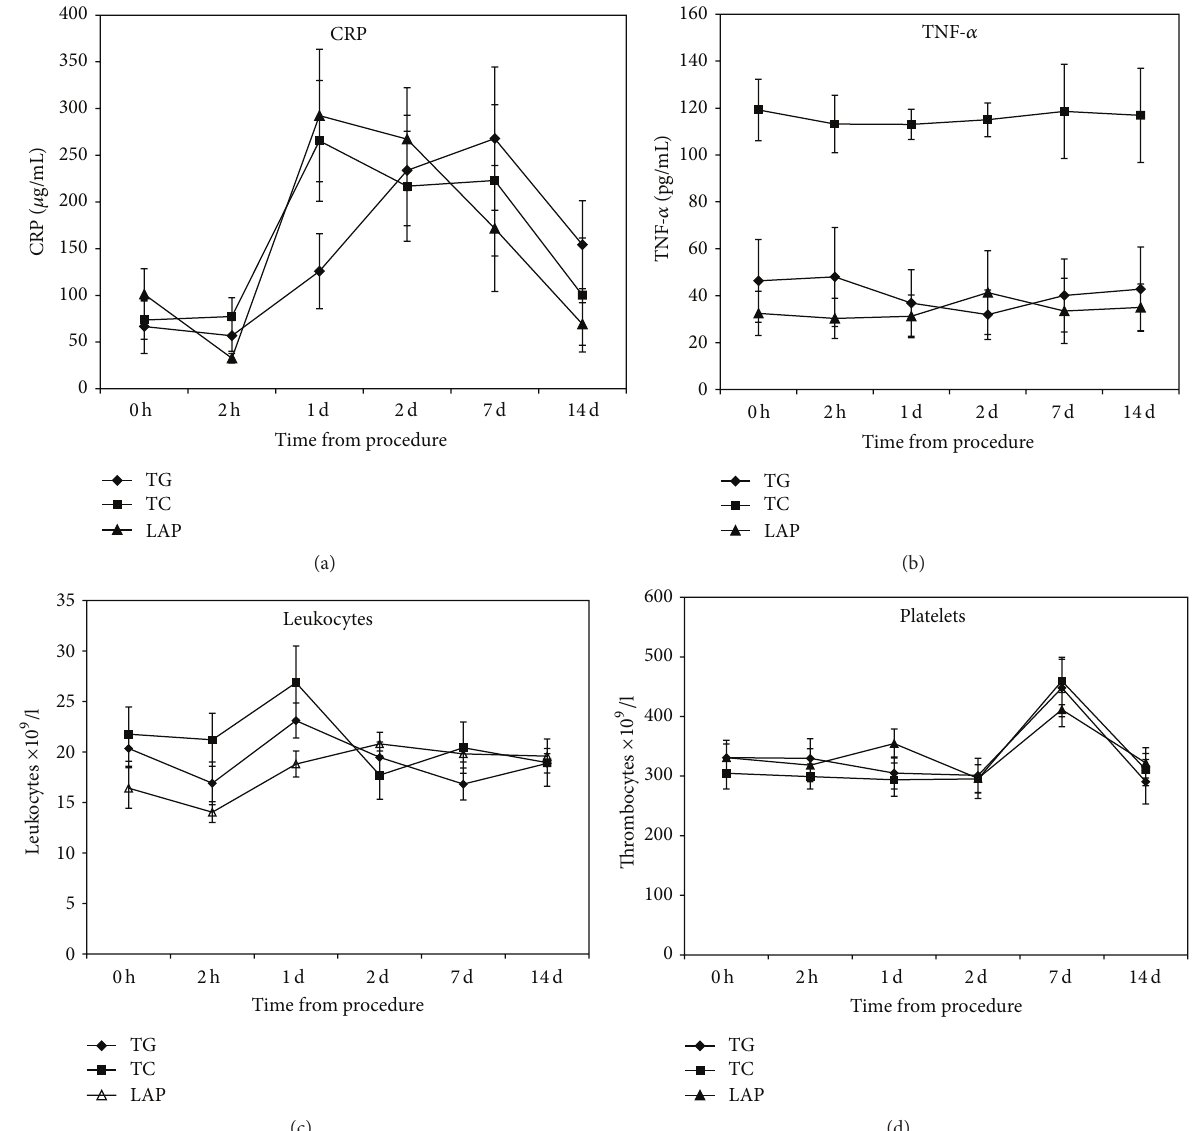
Figure 3: Comparison between transgastric, transcolonic, and laparoscopic peritoneoscopy in levels of (a) C-reactive protein; (b) TNF- 𝛼 ; (c) leukocytes; (d) platelets. Values are shown as means and vertical bars representing